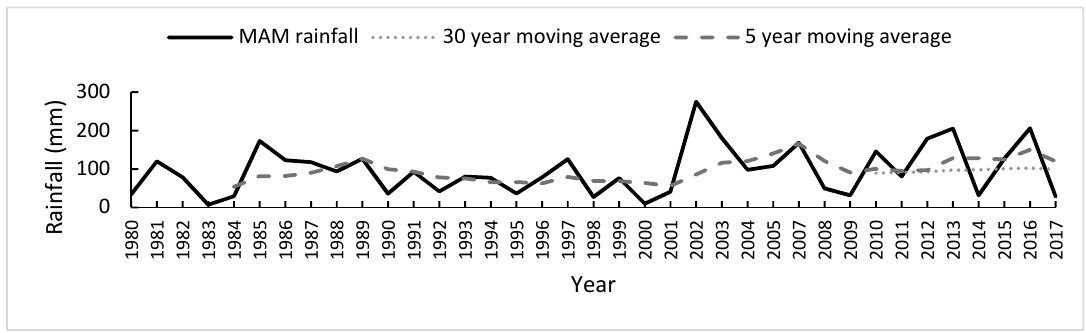
Figure 3. OND rainfall with 30-year moving average and 5-year moving average (source: Kenya Meteorological Department). Atmosphere 2020 , 11 , 1328